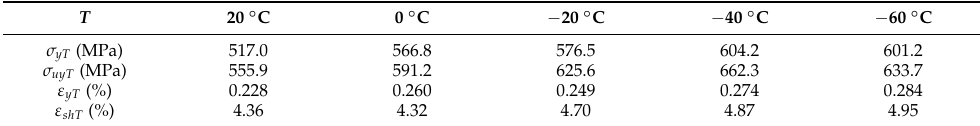
Table 4. Key stresses and strains of Mild-395/450 at subzero